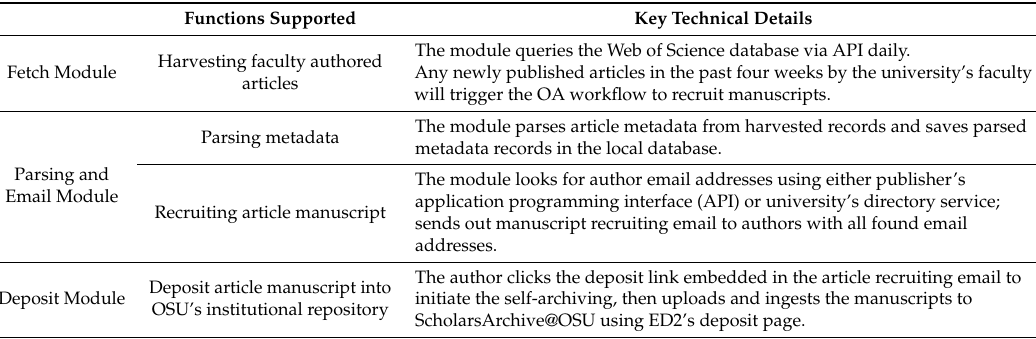
Table 1. Three Easy Deposit 2 modules with functions provided and key technical details such as data collection and integration from di ff erent